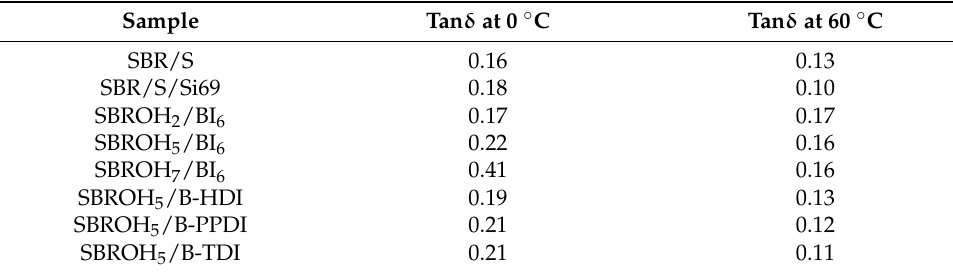
Table 4. Tan δ at 0 and 60 °C of composites.